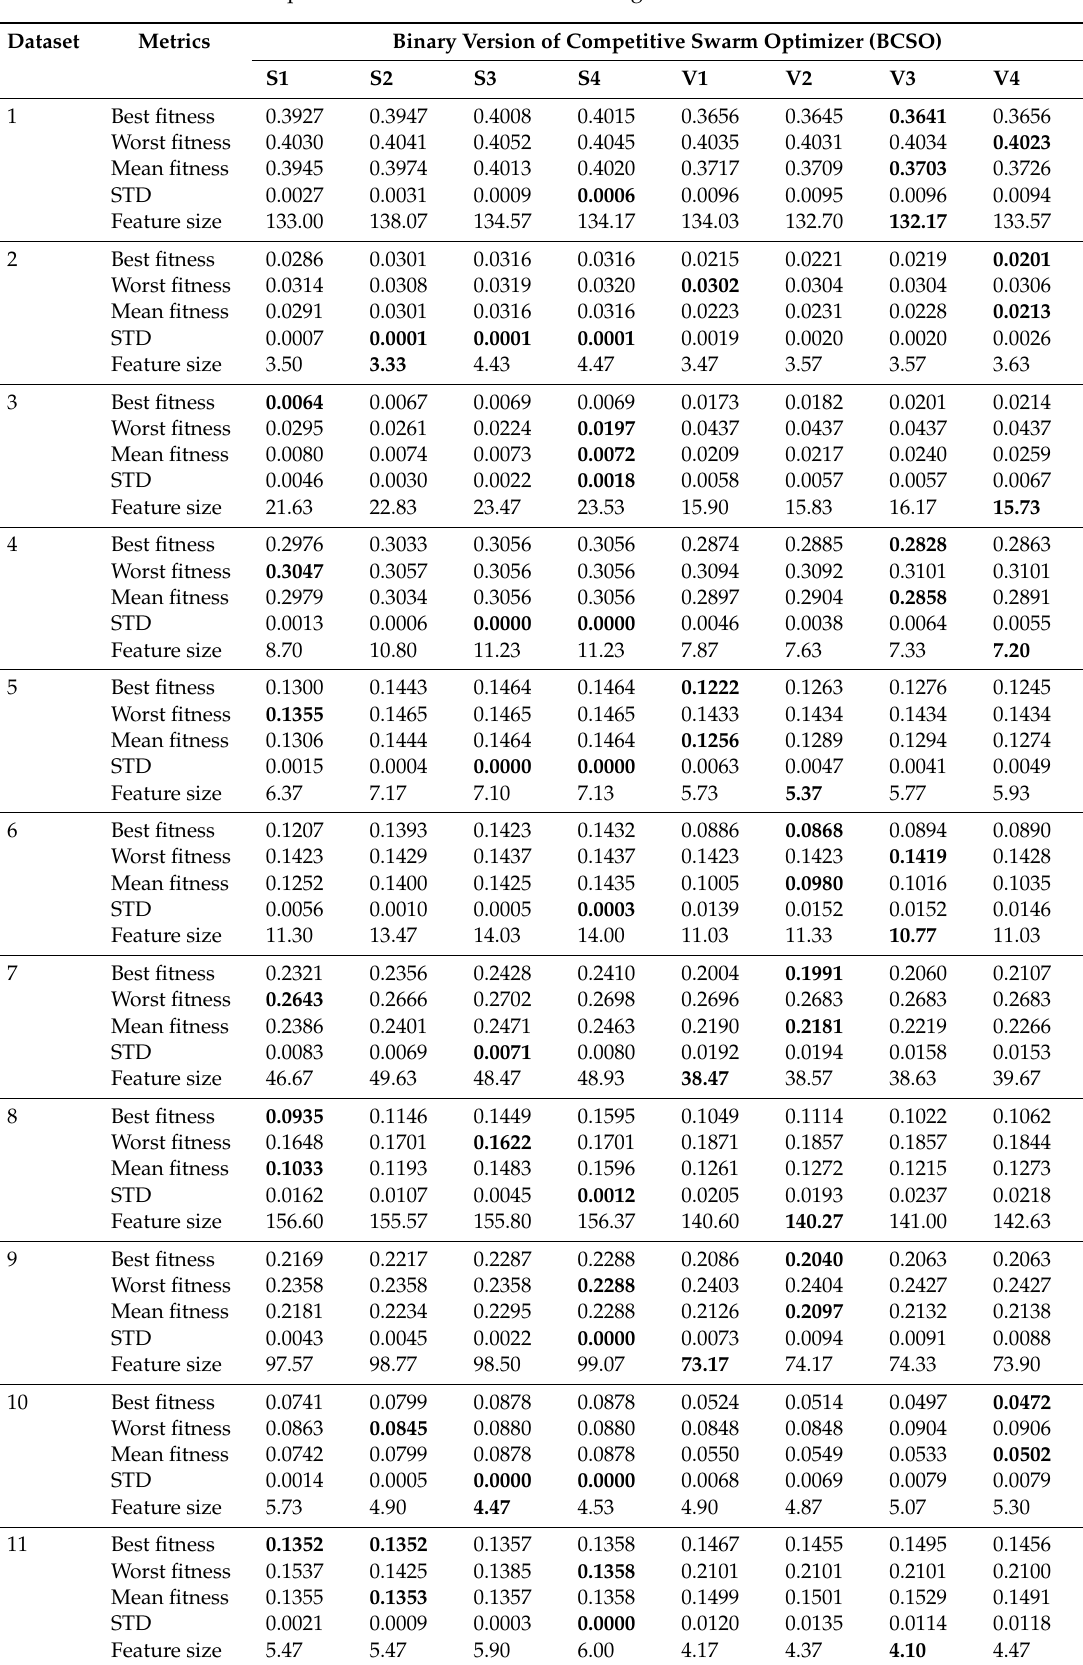
Table 3. The experimental results of BCSO with eight di ff erent transfer